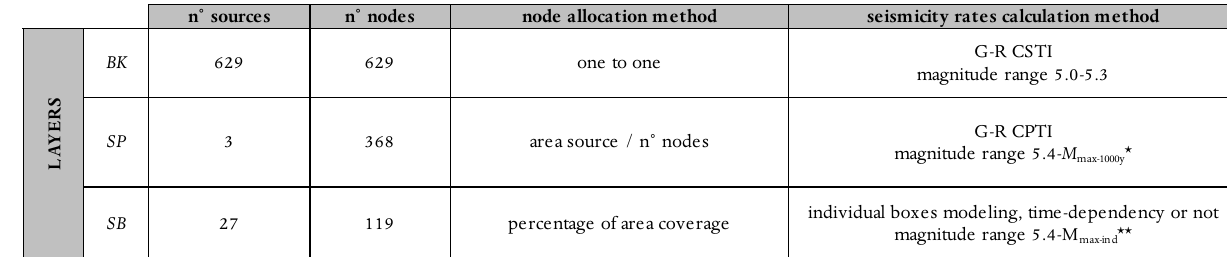
Table 1. Summary of information for each of the three layers of the LASSCI2009.2. BK, background layer; SP, seismotectonic provinces; SB, seismogenic boxes layer. For each layer, the number of sources is given with the total number of nodes of the CSEP-grid contained in the layer. The column «node allocation method» briefly describes how the total rates for each source were assigned to the nodes of the grid. The last column summaries the main method value corresponding to a mean recurrence time of ∼ 1,000 for the seismicity rate computations and the range of magnitudes covered by the layer (*: M max years; **: M value calculated from the geometry of each individual source; details in Pace et al. 2006). max